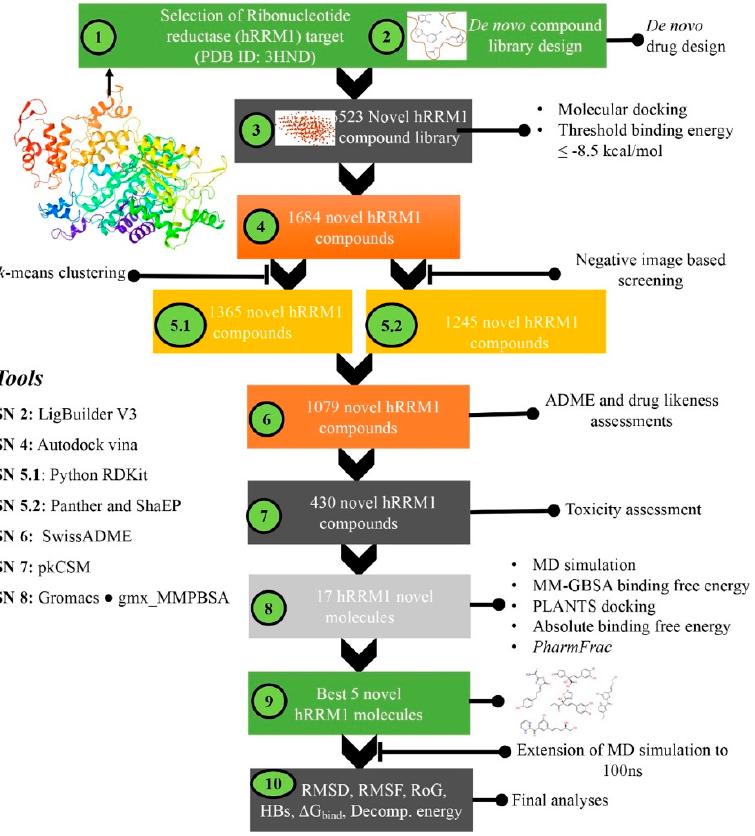
Figure 1. Schematic workflow for designing hRRM1 inhibitors using de novo drug design and virtual screening approaches.